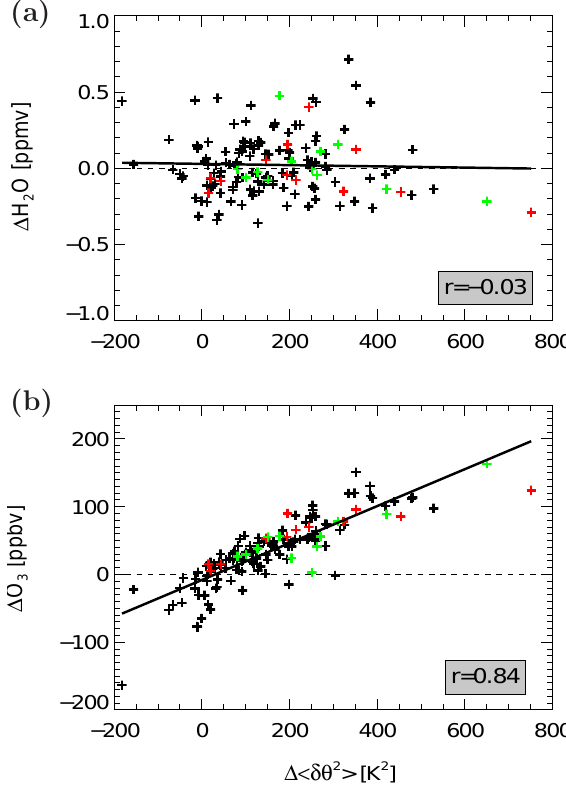
Fig. 6. Anomaly (from tropical mean) of kinematic-diabatic disper- sion h δθ 2 i difference (a) and ozone difference (b) at 400K on 20 November 2005. Data is binned into 13 ◦ × 90 ◦ latitude-longitude bins. Red/blue indicates positive/negative anomaly. Note that the pattern varies with time (see also Fig. 7).